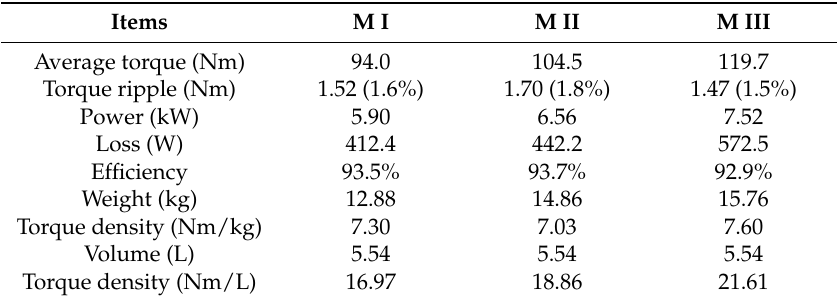
Table 2. Main rated load performance of the three machines.